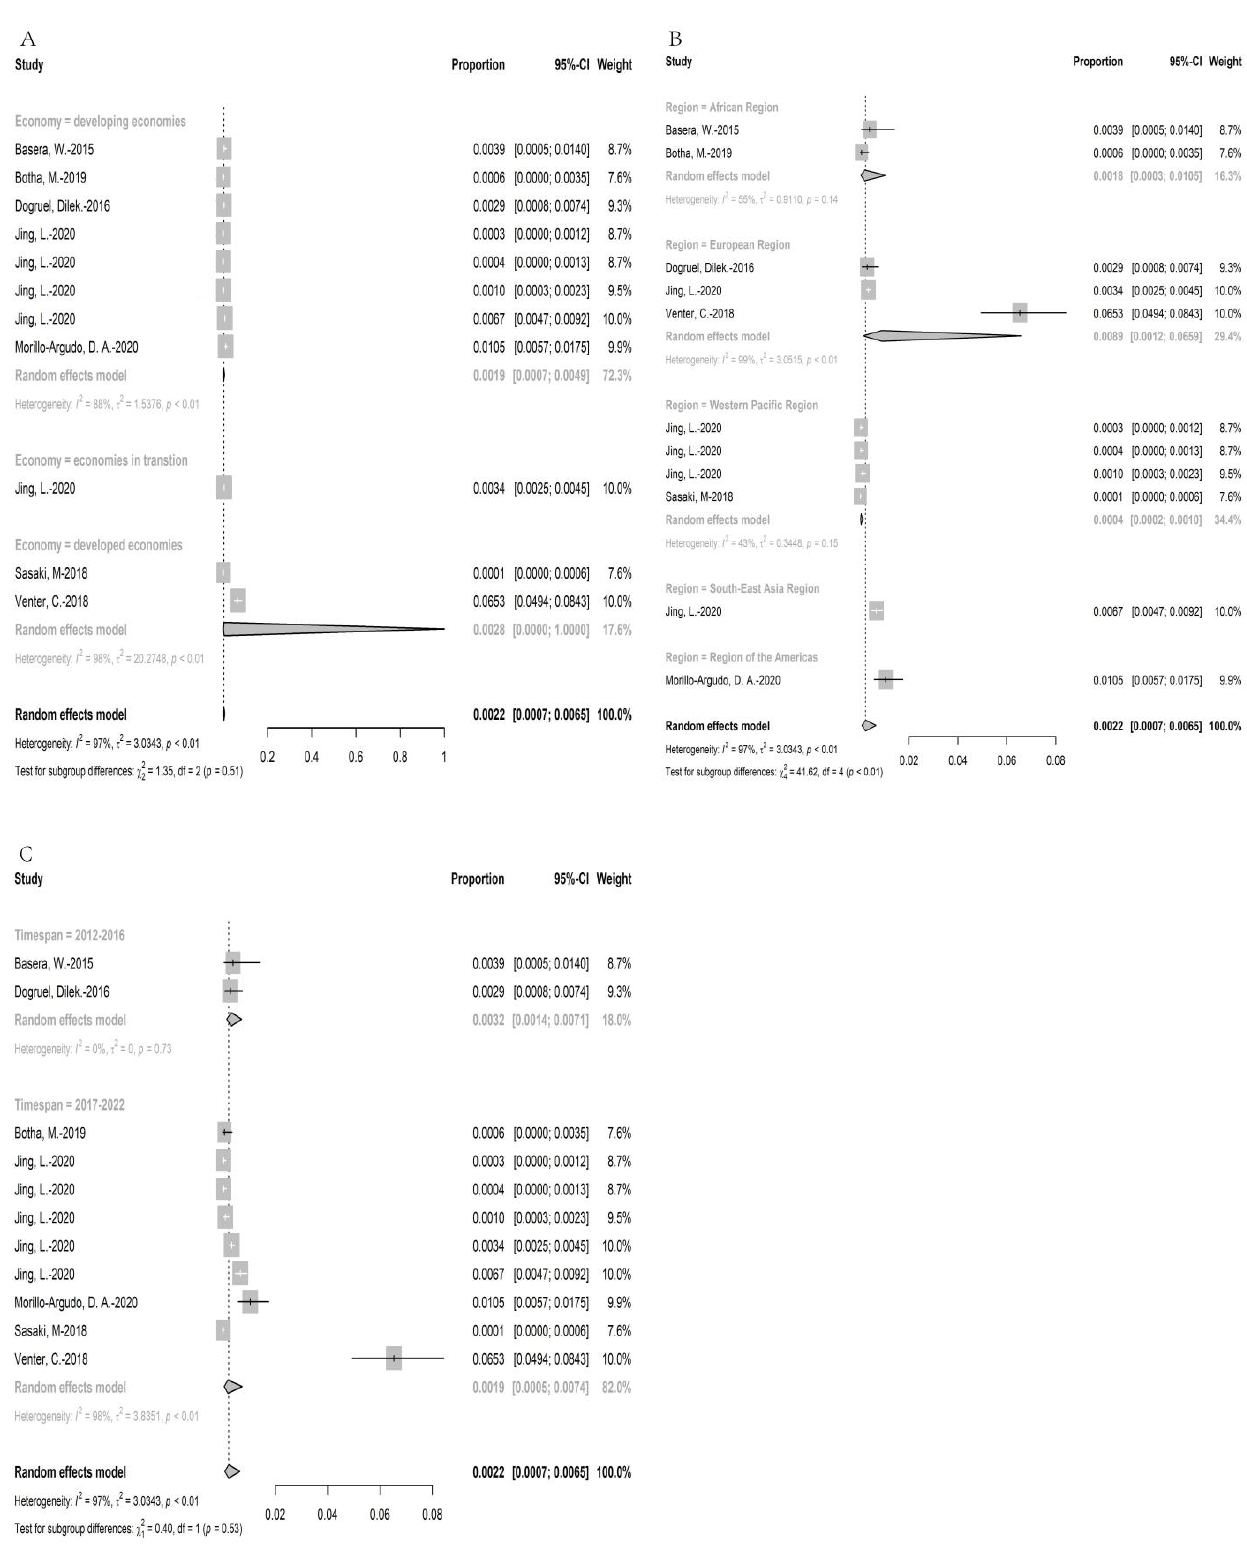
Figure 4. The prevalence of wheat allergy for skin prick test positive; ( A ): the subgroup analysis for economy; ( B ): the subgroup analysis for region, ( C ): the subgroup analysis for timespan [20,22,24,25,38,43,52,61].